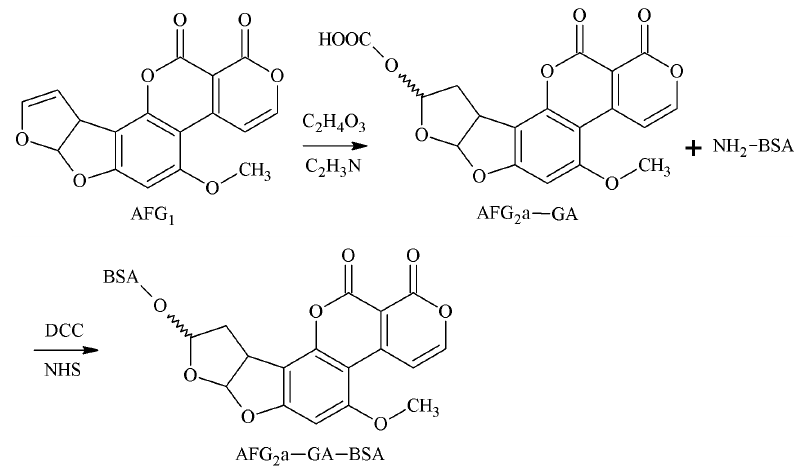
Figure 11. Synthesis of the AFG1-BSA antigen via the EED method.